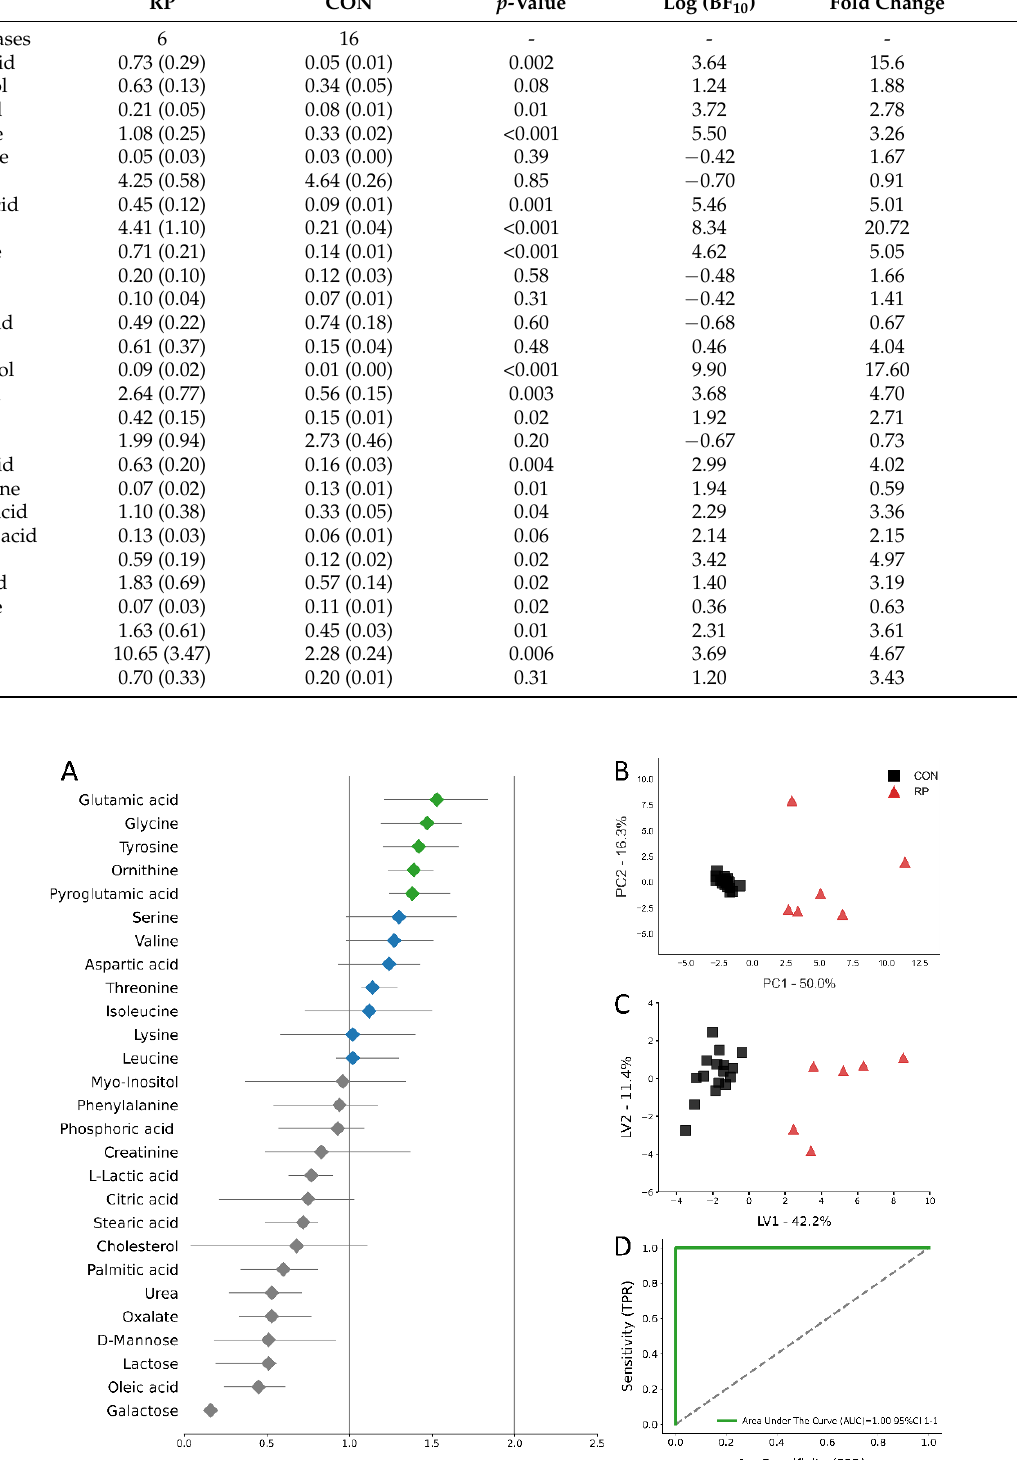
Figure 5. ( A ) Variables ranked by variable importance in projection (VIP), ( B ) PCA, ( C ) PLS-DA (permutation test: p < 0.05) of 16 healthy control (CON) cows and 6 pre-RP cows at −4 weeks prior to parturition. ( D ) ROC curve for five top-performing metabolites in Vip Scores.